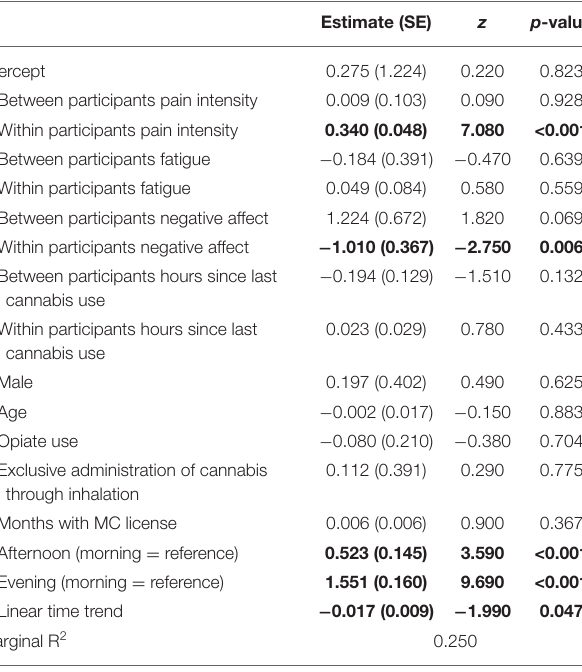
in the next hour ( N = 78). Estimate